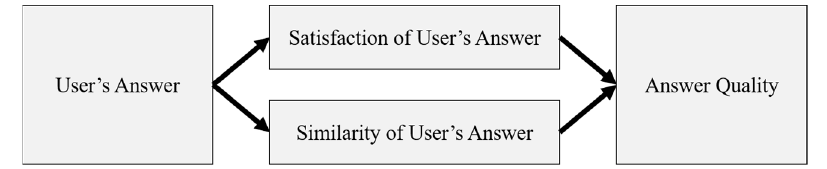
Figure 5. Procedure of determining the answer quality.